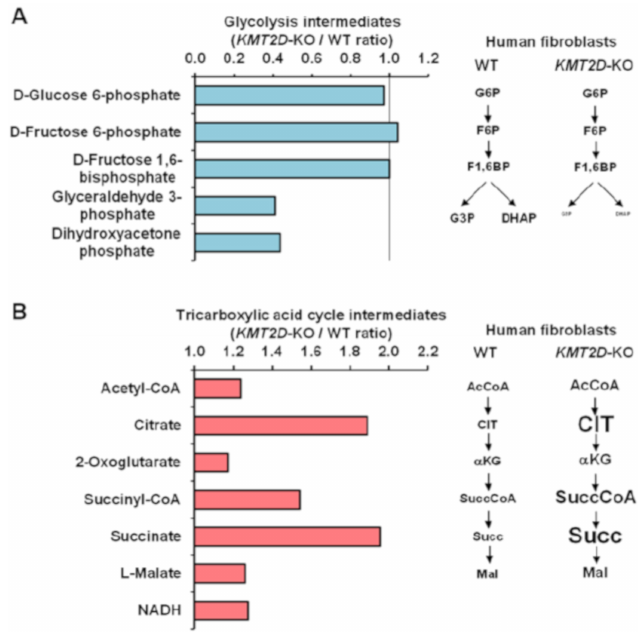
Figure 2. Mass spectrometry analysis of metabolites in wild type (WT) and KMT2D -KO fibroblasts. The histograms in ( A , B ) show the relative amounts of intermediate metabolites of glycolysis and the tricarboxylic acid cycle, respectively, in KMT2D -KO fibroblasts as compared with isogenic WT cells. The bars are averages of two biological replicates yielding similar results. The pathways on the right represent the fold change of the indicated metabolites in KMT2D -KO cells as compared with those in WT cells.